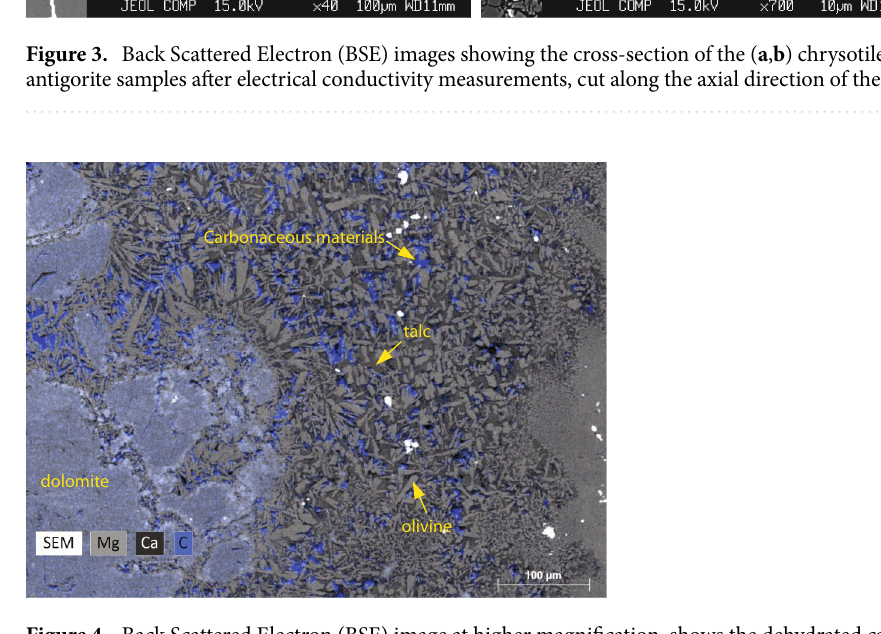
Figure 4. Back Scattered Electron (BSE) image at higher magnification, shows the dehydrated carbonate- bearing chrysotile sample. The BSE image is overlain with the energy-dispersive X-ray (EDX) spectroscopy which shows the mapping of Mg (light gray), Ca (dark gray), and C (blue). The concentrations of blue regions indicate precipitation of carbonaceous materials within the olivine and talc grain